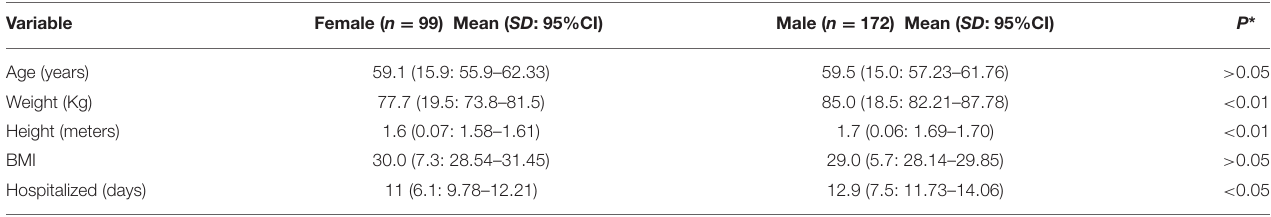
TABLE 1 | Demographic data from SARS-CoV-2 patients. Variable